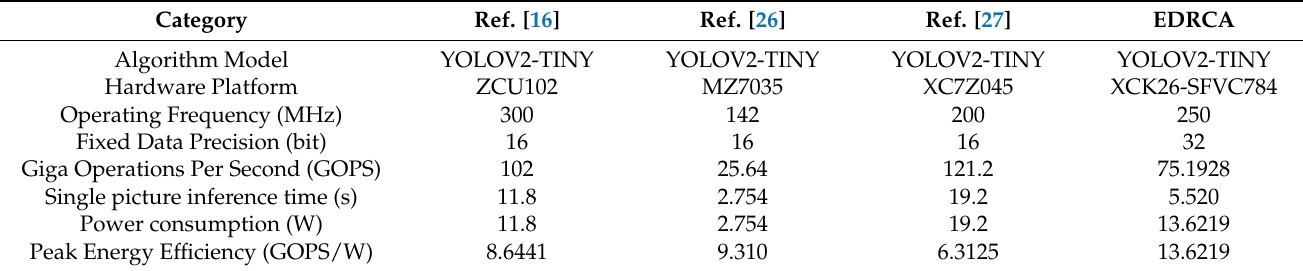
Table 4. Results of EDRCA versus related